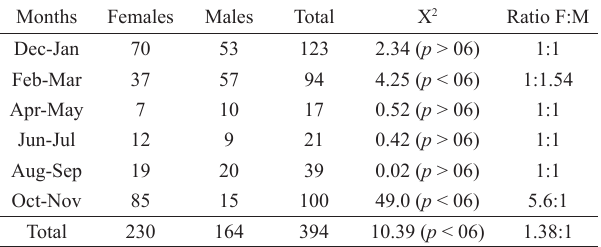
Table 1. Total and bimonthly sex ratio of Loricariichthys melanocheilus in the rio Ibicuí, Rio Grande do Sul.